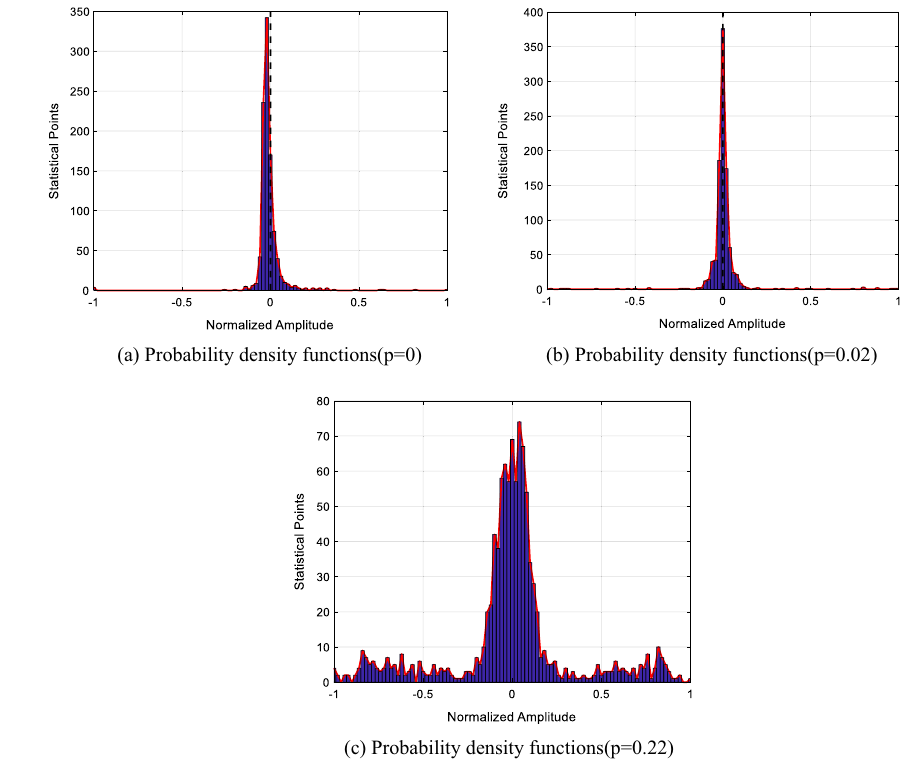
Fig. 2 Probability density distribution of three cases